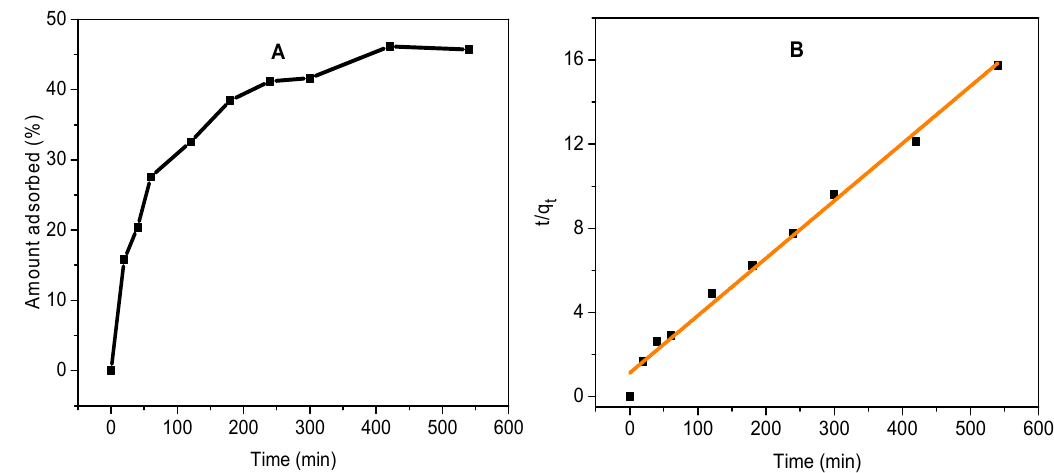
Figure 4. The effect of the amount of TC adsorbed as a function of contact time ( A ) and pseudo-second-order kinetic plot for the adsorption of TC ( B ).